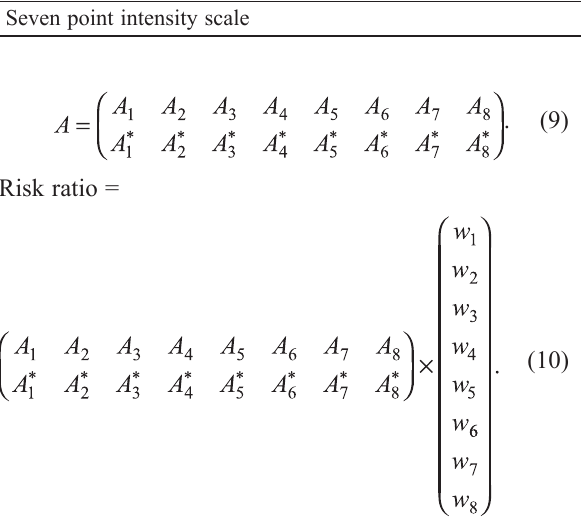
Table 3. Relation between rating scale and equivalent seven point intensity scale of pairwise comparison matrix Rating in the